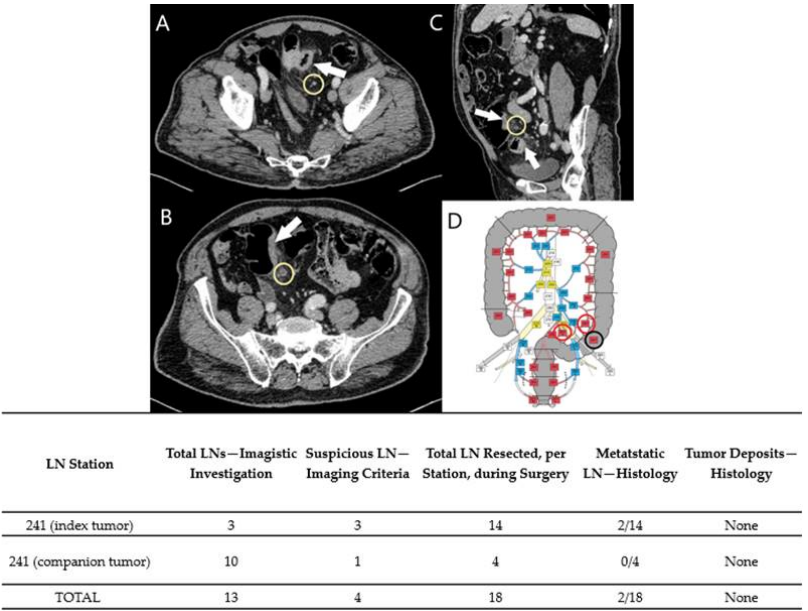
Figure 4. Case No. 5. Two synchronous sigmoid tumors. Parietal thickening of the colic wall with contrast-enhancement (white arrows), infiltration of pericolic fat. Association of regional LNs (yellow circle), some with suspicious criteria, seen on contrast-enhancement CT scan, venous-phase, axial-views ( A , B ) and sagittal view ( C ). A map of nodal stations was made: black circle: visible, non-suspicious LNs, red circle: suspicious LNs ( D ). Table: correlation of LNs stations - two of the four suspect LNs were positive, both of them found in the index